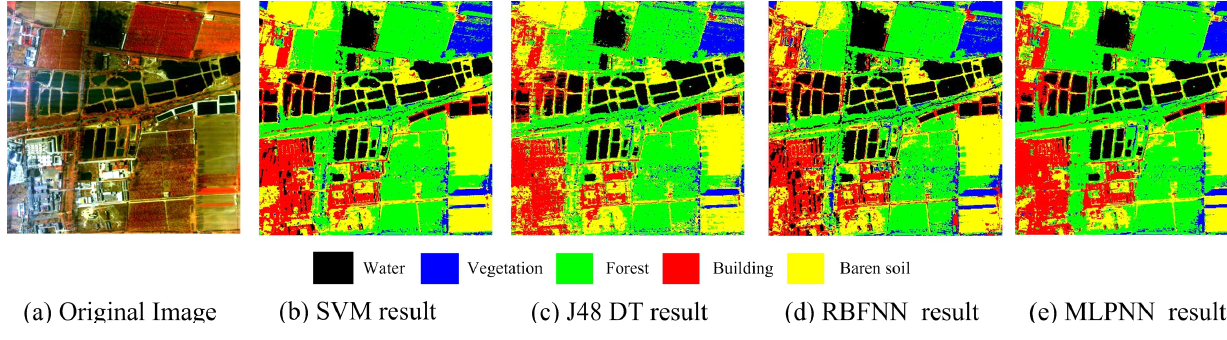
Table 9. Classification accuracy of single classifier.